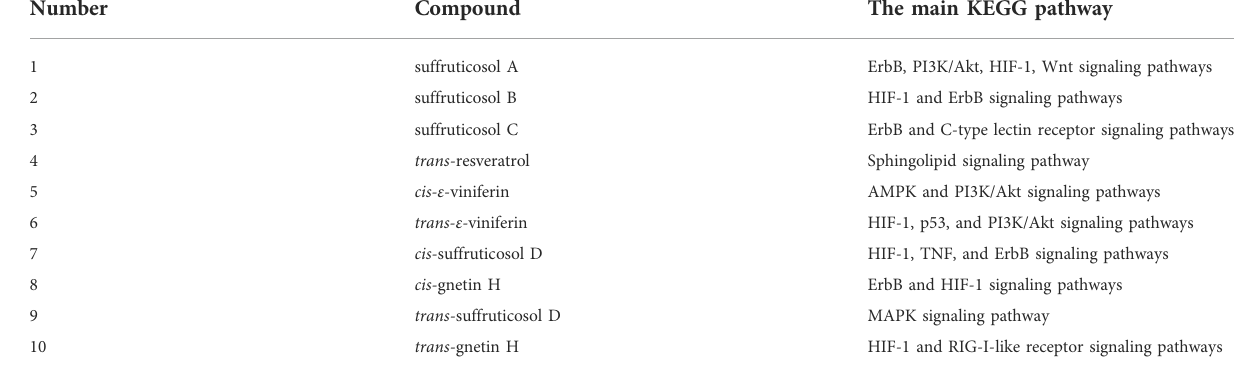
TABLE 1 The main KEGG pathways enriched by DEGs on 10 stilbenes.